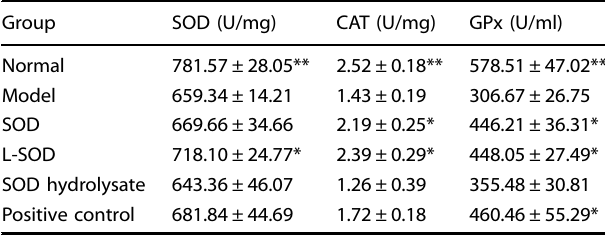
Table 1. Antioxidant enzymatic activities of SOD, CAT, and GPx in colon tissues.